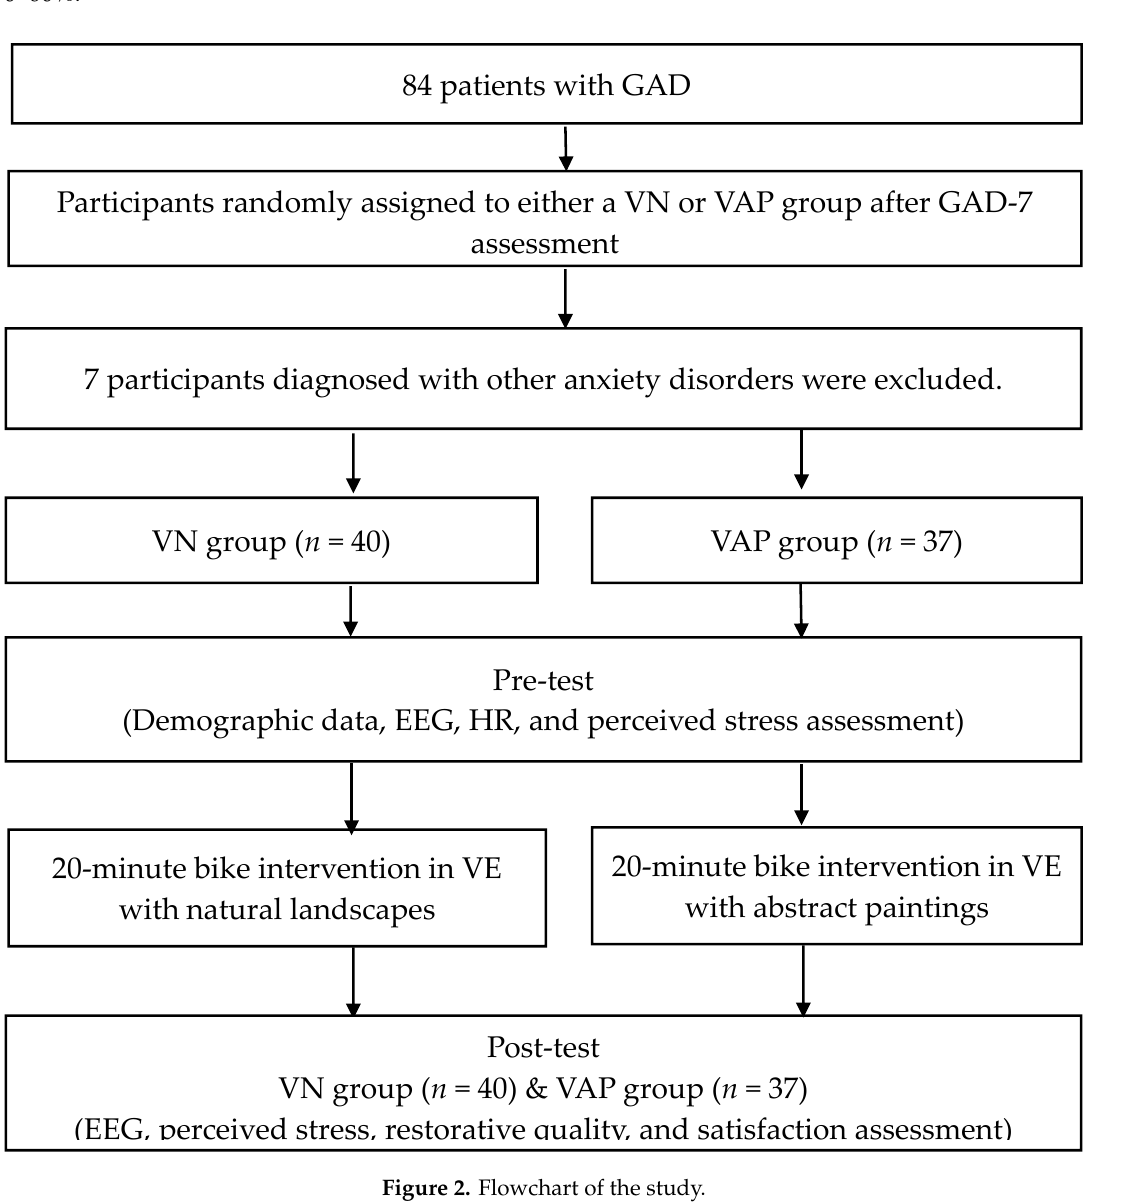
Figure 2. Flowchart of the study.